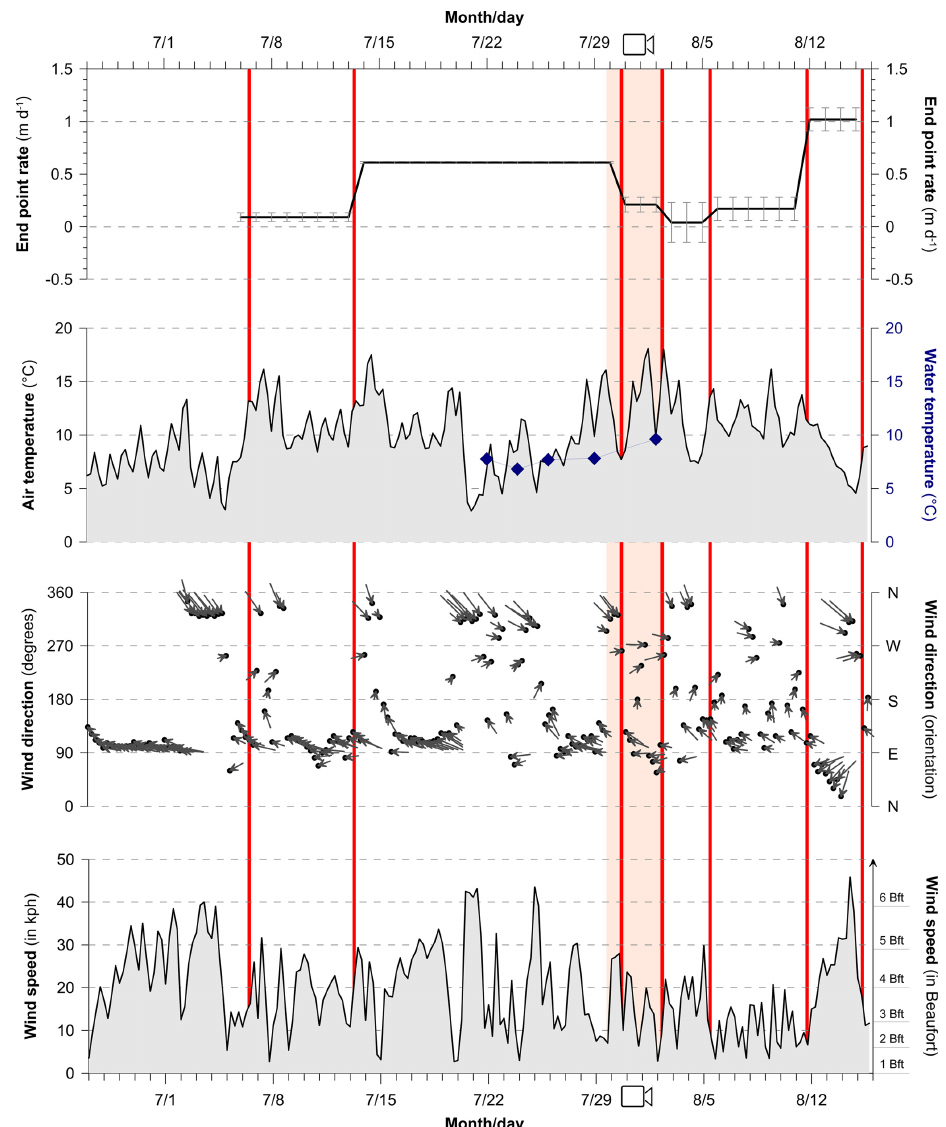
Figure 5. Shoreline retreat (end point) rates normalised by day for each observation period in 2017, 6h moving averages of air temperature, wind direction, and wind velocity in July–August 2017 (data from Environment Canada, 2017). Dates and times of aerial surveys are indicated by the red bars, point measurements of sea surface temperature from CTD casts are indicated by blue diamonds (see Fig. S3 for full CTD profiles), and the duration of time-lapse survey shown in Video S1 is indicated by the red